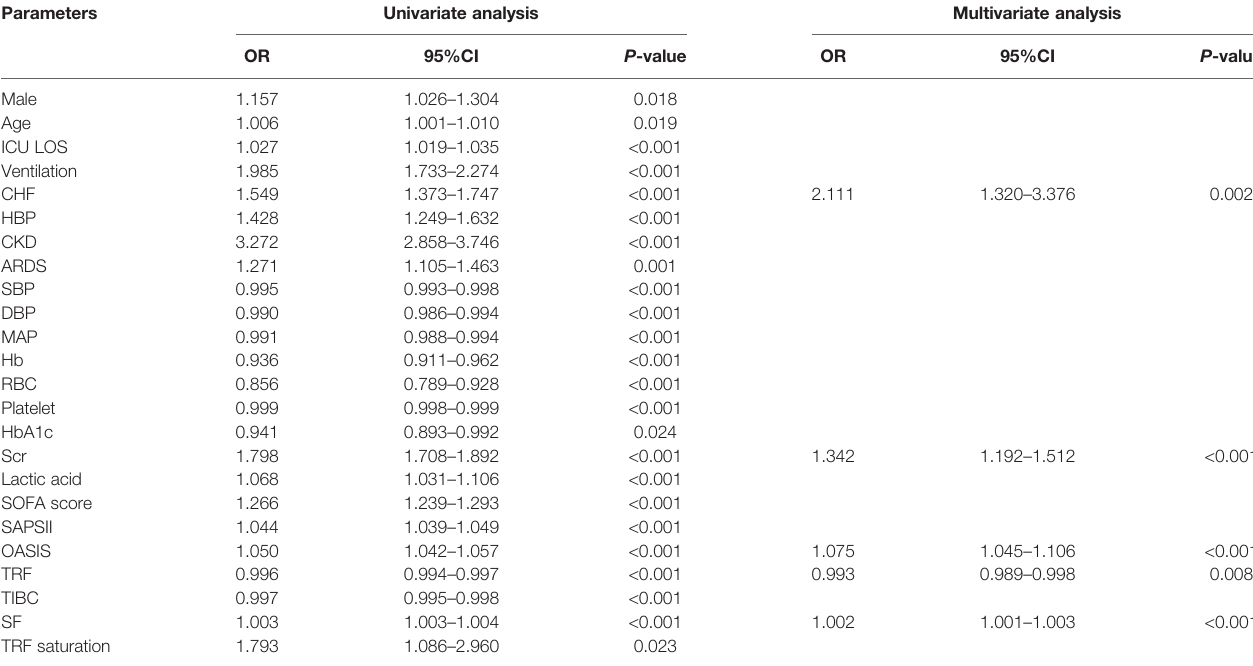
TABLE 2 | Logistic regression analysis for acute kidney injury in critically ill patients with diabetes. Parameters